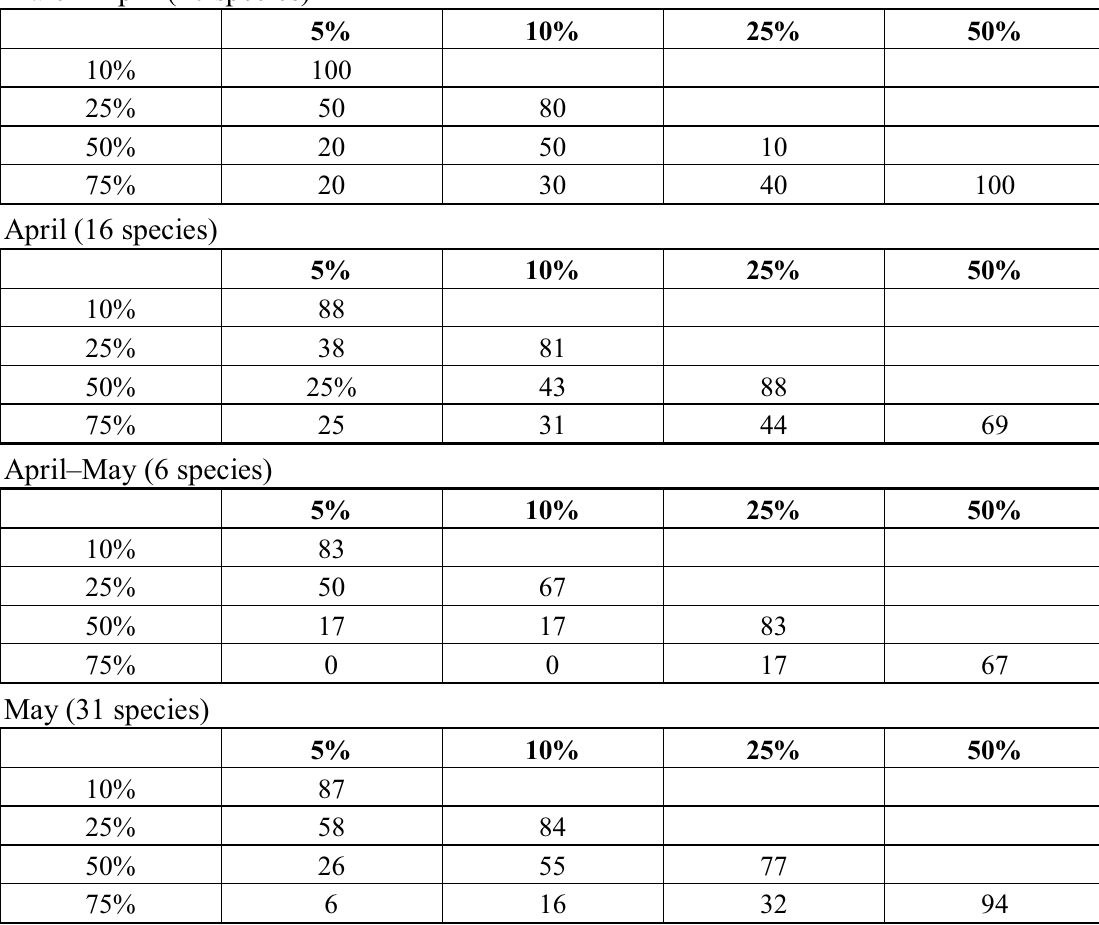
Table 4. Percentage of species whose various medians show a significant Pearson correlation ( p <